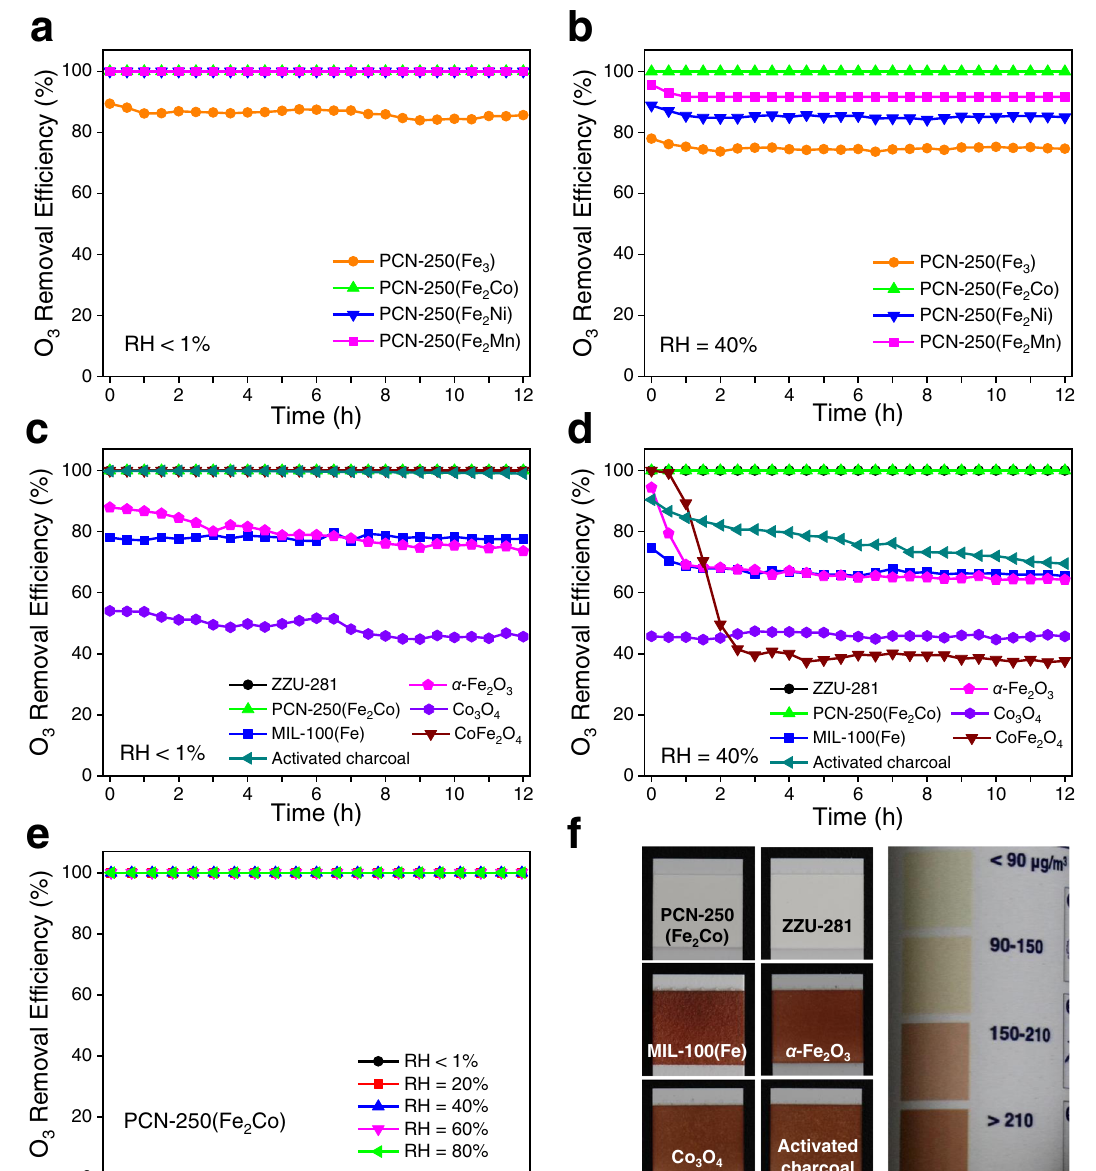
Fig. 2 | The O 3 removal ef fi ciencies for PCN-250 and other reference materials. a RH<1% (zero air) and b RH=40% for the PCN-250 samples. c RH<1% (zero air) and d RH=40% for PCN-250(Fe 2 Co), ZZU-281, MIL-100(Fe), α -Fe 2 O 3 , Co 3 O 4 , CoFe 2 O 4 , and activated charcoal. e Varied RHs for PCN-250(Fe 2 Co). Other